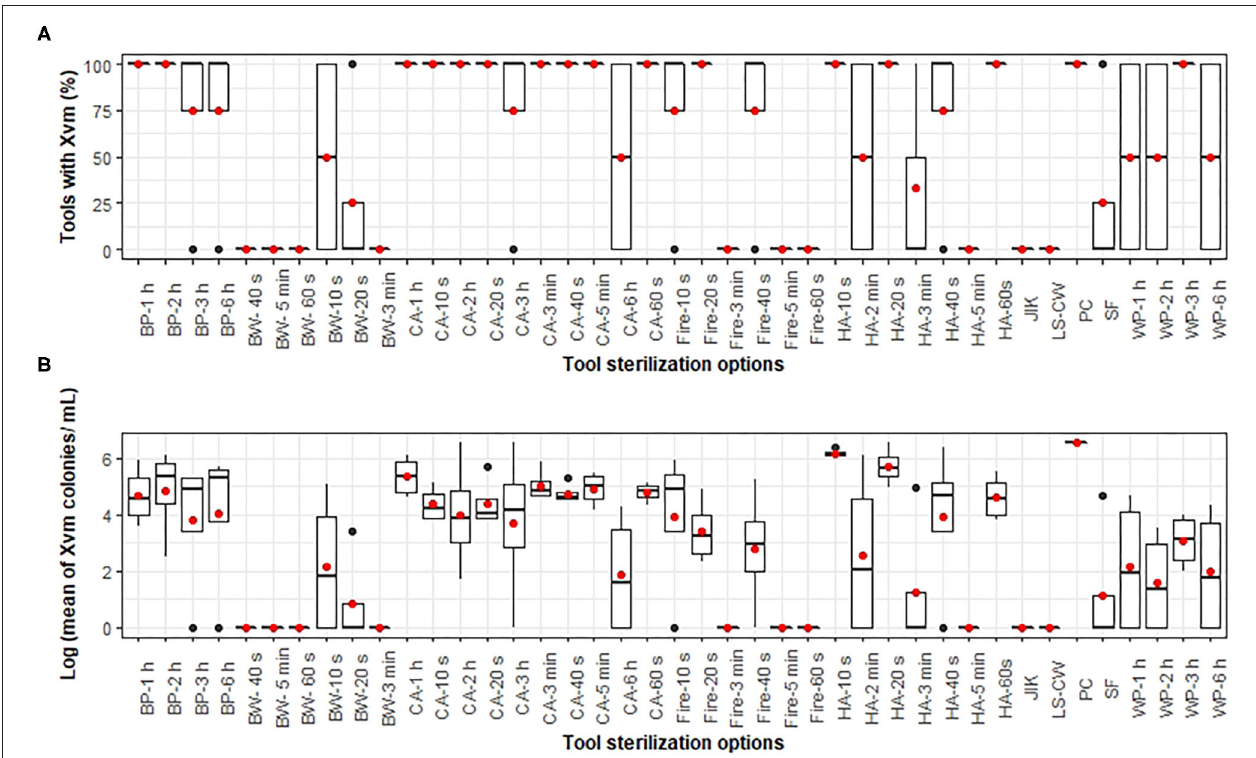
FIGURE 1 | The (A) percentage of tools with Xanthomonas vasicola pv. musacearum ( Xvm ) and (B) log 10 of the mean number of Xvm colonies per mL recovered from contaminated farm tools following cleaning with different methods or storage. 3.5% sodium hypochlorite (Household bleach) served as the negative control or best cleaning method whereas uncleaned freshly contaminated tool blades served as the positive control (PC). BP, BW, CA, HA, LS-CW, SF, and WP, respectively denote black polythene sheet, boiling water, cold ash, hot ash, laundry soap, and cold water, repeatedly inserting tool with shear force into the soil, and white polythene sheet. The horizontal “black lines” and “red points” within the boxes are, respectively, the median and mean values of the percentage of tools with Xvm or Xvm colony counts. The lower and upper boundaries of the boxes are, respectively, the 25th and 75th percentile; the bars/whiskers below, above the box are the 10th and 90th percentile and points beyond the 25th and 75th percentiles are